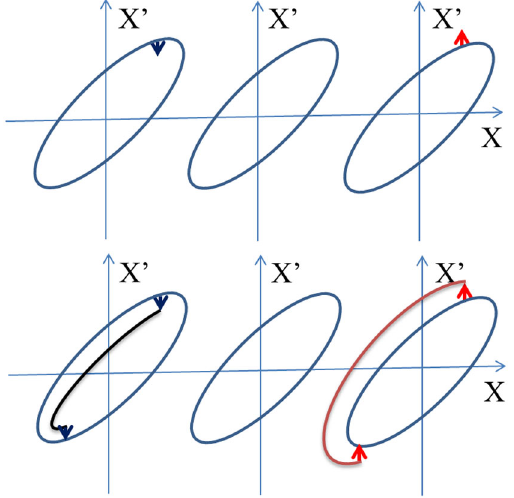
FIG. 7. The cancellation scheme of the residual kick with two identical kickers. A single particle in the phase space, receives two identical residual kicks with 180 degrees phase advance in x-x ’ plane, and returns to its original phase space